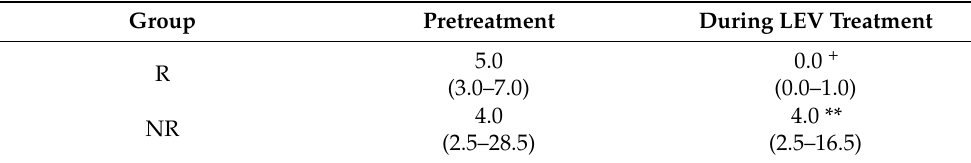
Table 2. Effect of levetiracetam treatment on spontaneous recurrent seizures in epileptic rats.